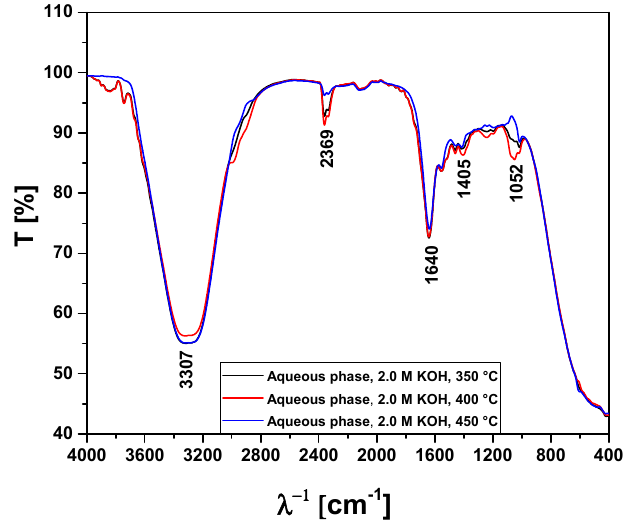
Figure 9. FT-IR analysis of aqueous phase obtained by pyrolysis of Açaí seeds, activated with 2.0 M KOH solution, at 350, 400, and 450 °C, 1.0 atmosphere, in laboratory scale. Table 5. Absorption bonds and chemical functions identified by FT-IR analysis of aqueous phase obtained by pyrolysis of Aça í seeds, activated with 2.0 M KOH solution, at 350, 400, and 450 ◦ C, 1.0 atmosphere, in laboratory scale. Absorption Bands